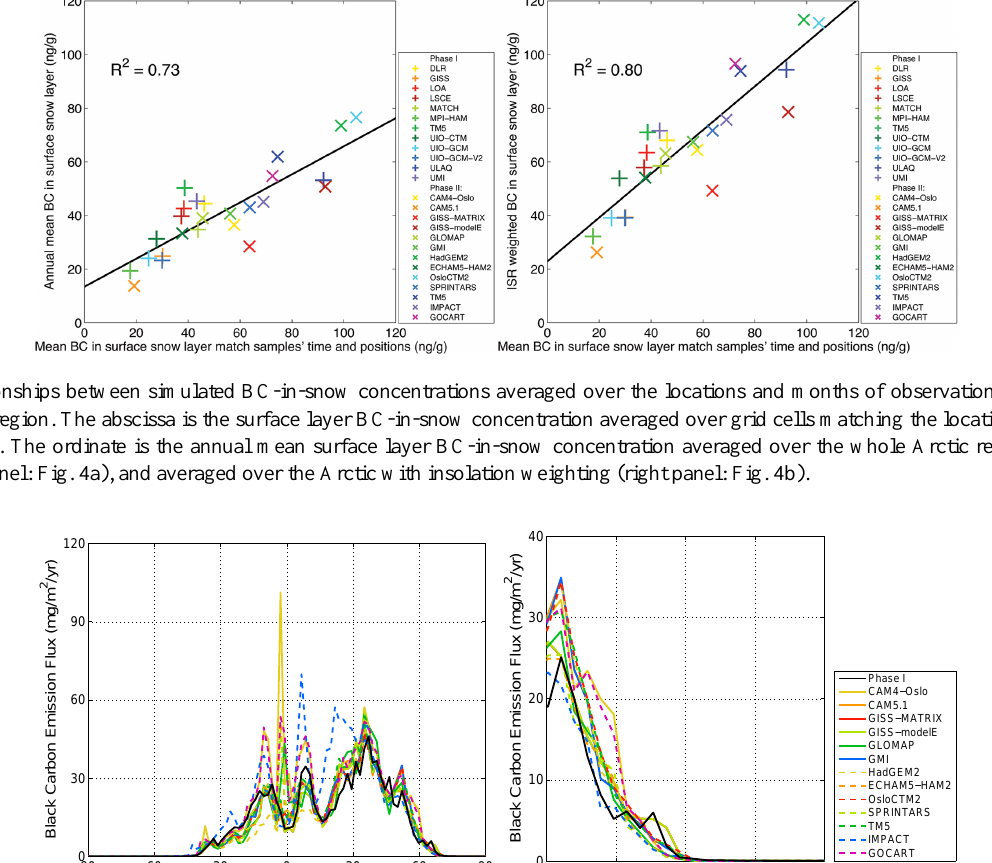
Fig. 6. Annual, zonal-mean black carbon deposition fluxes for Phase I (left) and Phase II (right) models. (Note the scale on ordinate is different for the two plots.)